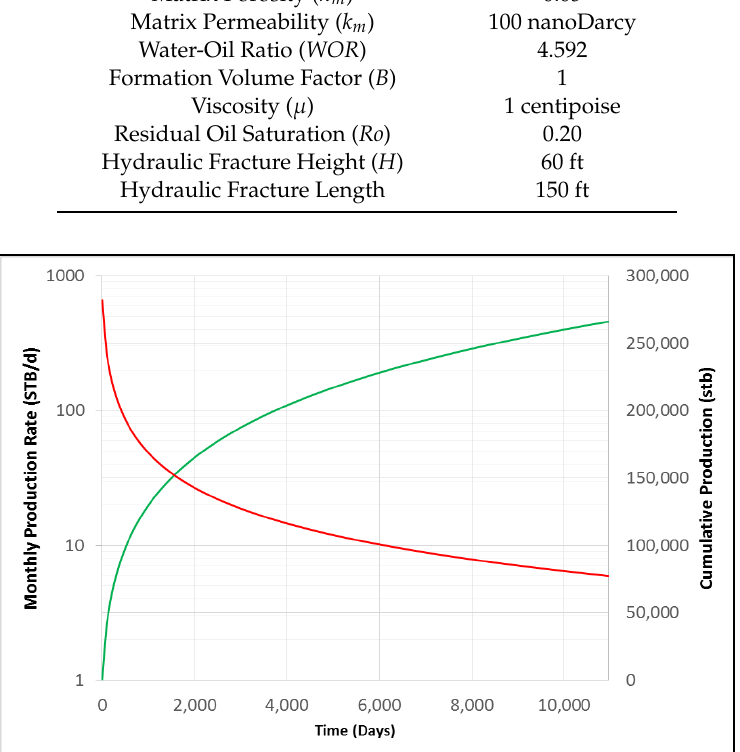
Figure A1. Arps hyperbolic decline curve model used to history match field data to give: (1) Production rate (STB/day, left scale, red curve) and (2) cumulative production (STB, right scale, green curve) for well after forecasted time of 30 years (10,958 days).